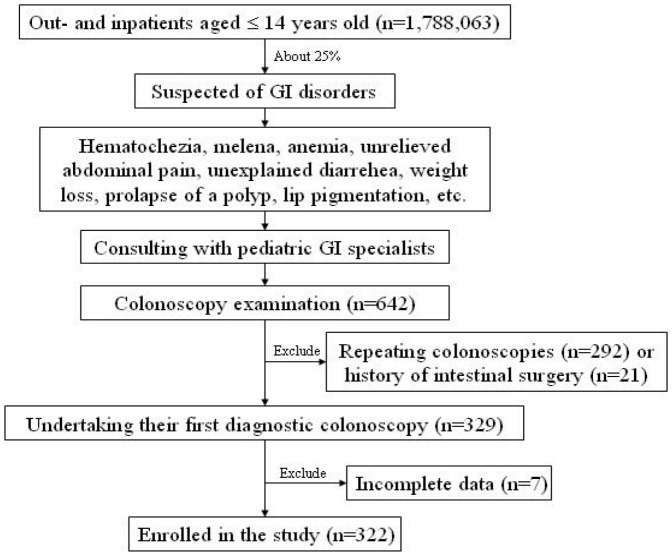
Management protocol for this study.Children aged ≤14 years old undertaking their first diagnostic colonoscopy at the endoscopy center of the First Affiliated Hospital, Sun Yat-sen University between Jan. 1, 2001 and Dec. 31, 2012 were enrolled in the study.